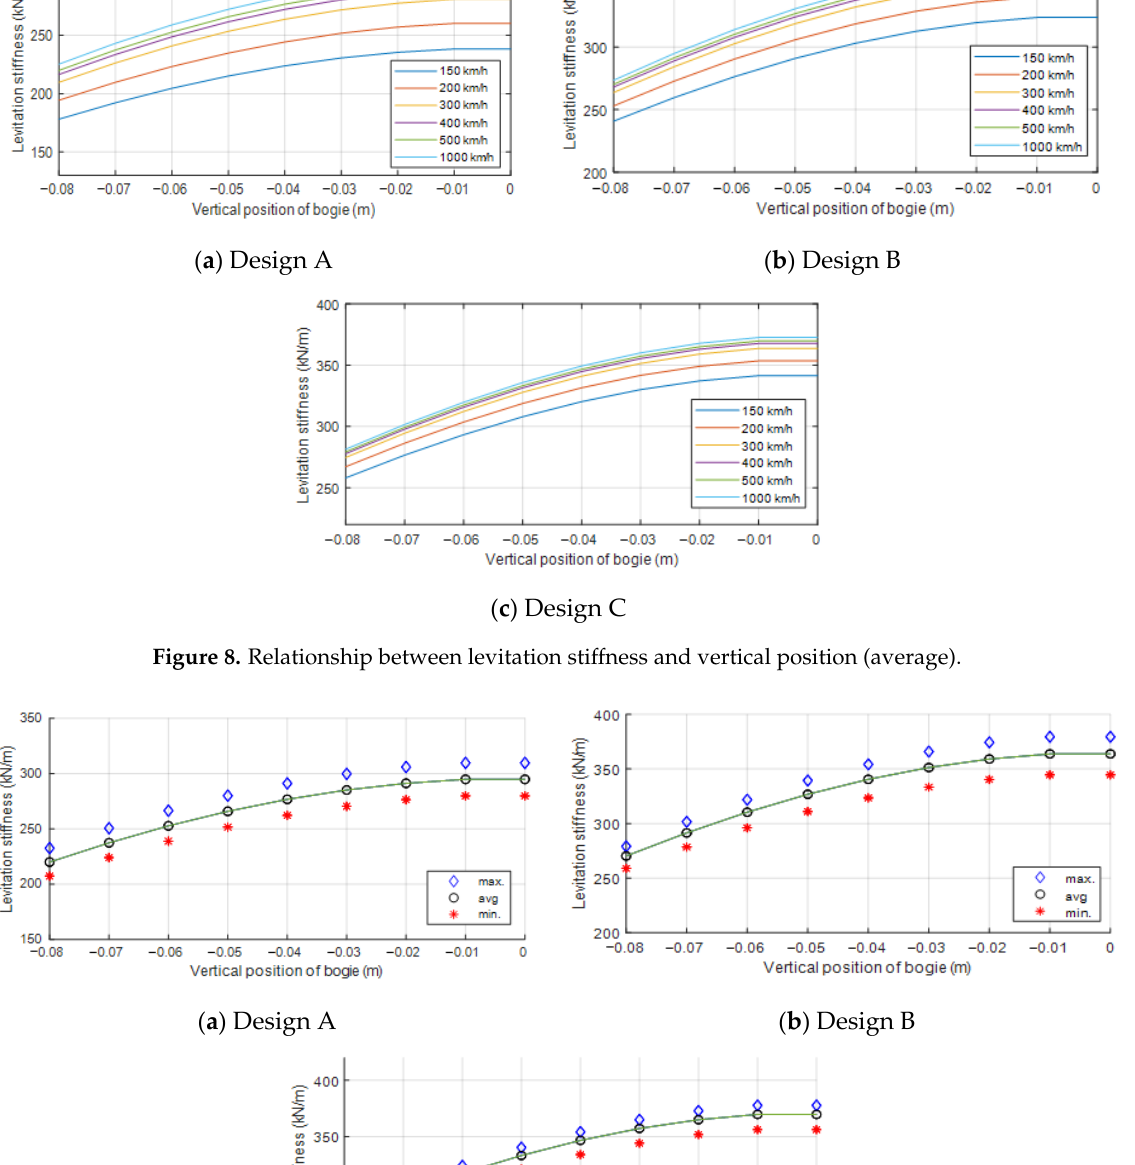
Figure 9. Relationship between levitation stiffness and vertical position (average and fluctuation).